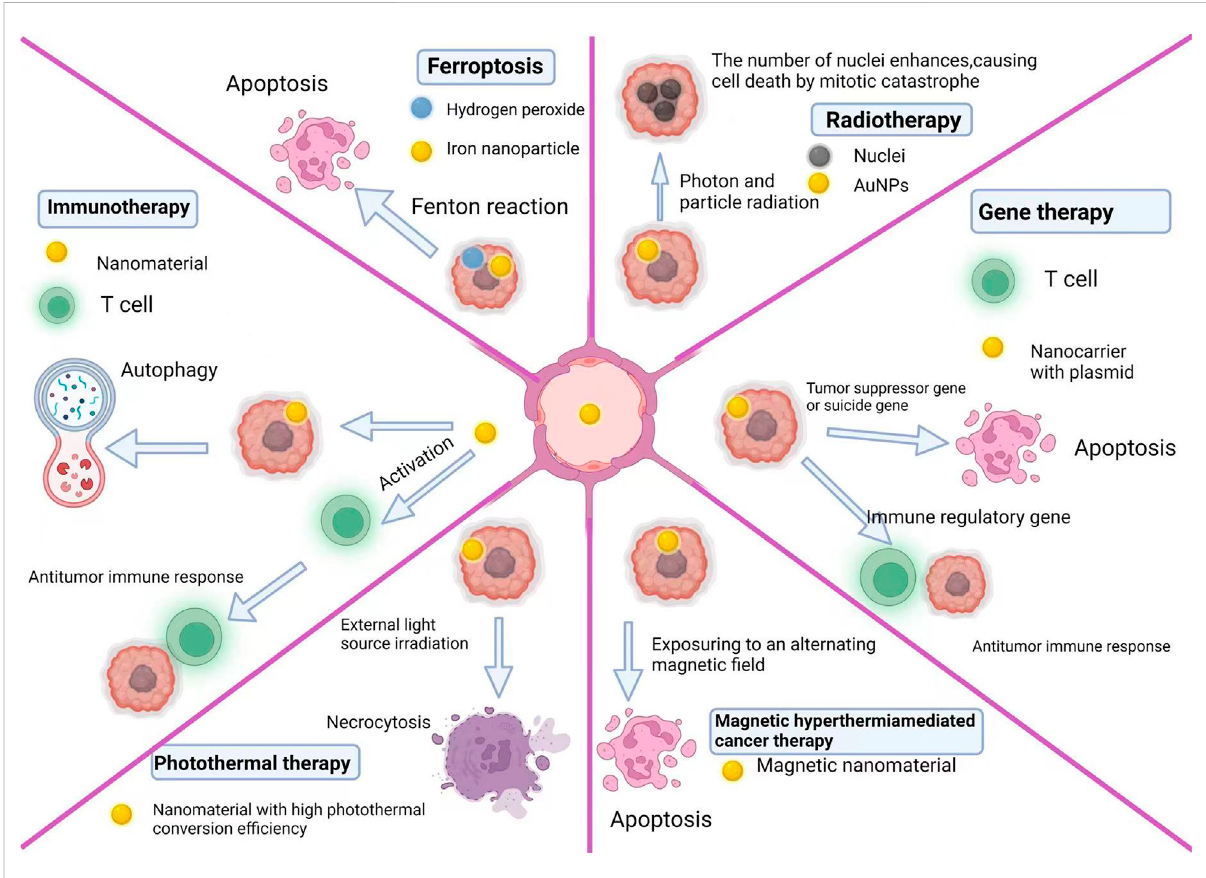
FIGURE 2 Glioblastoma therapy mechanism of